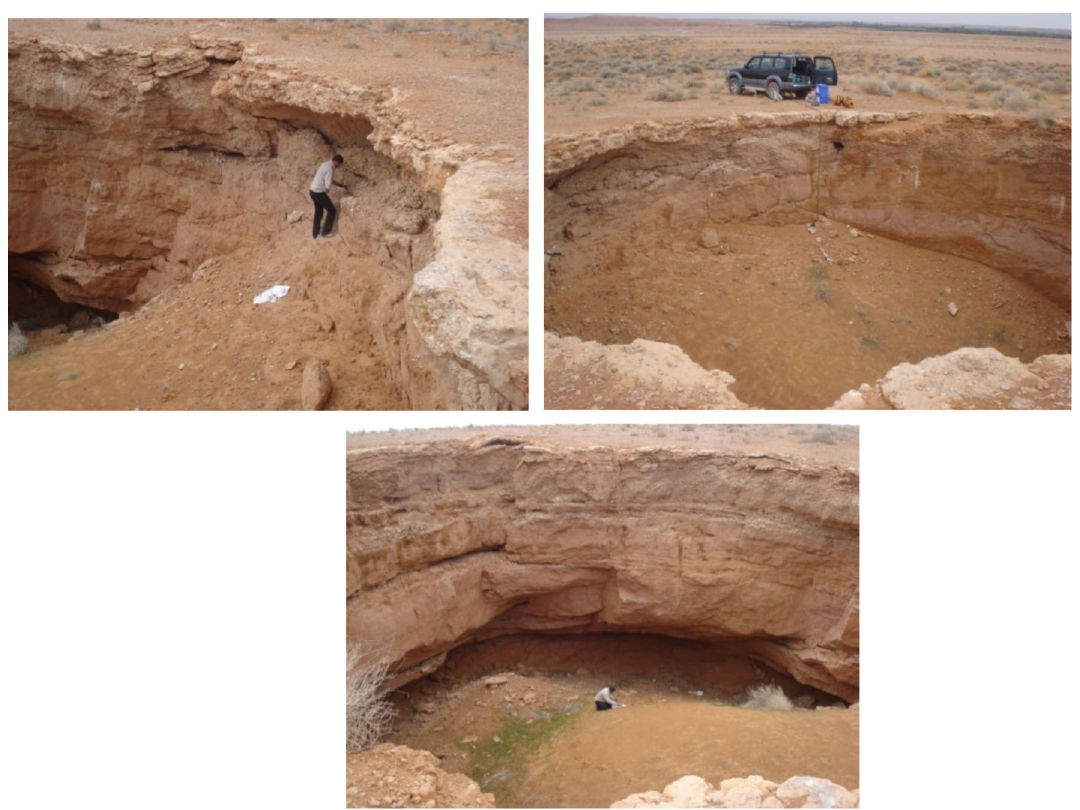
Fig. 2 Direct in situ resistivity measuring around the study